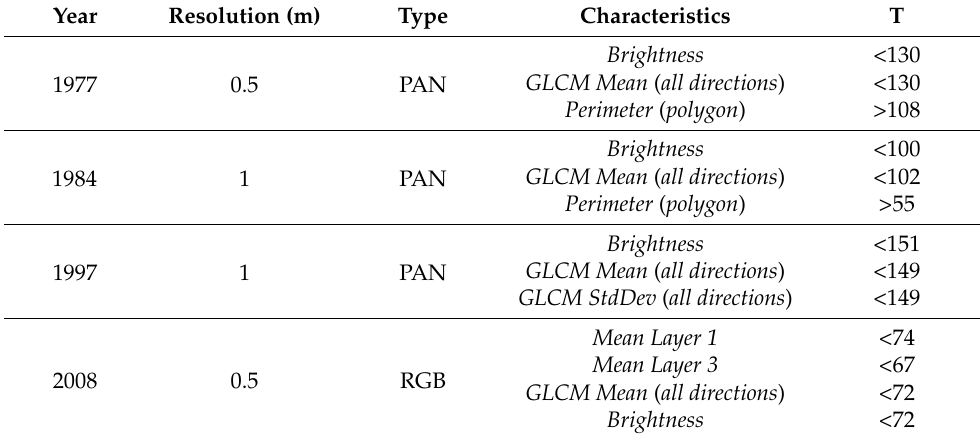
Table 6. Features and T-thresholds used by fuzzy logic in the images. The T-thresholds indicate the threshold values for each feature that produce the greatest differentiation between the classes.